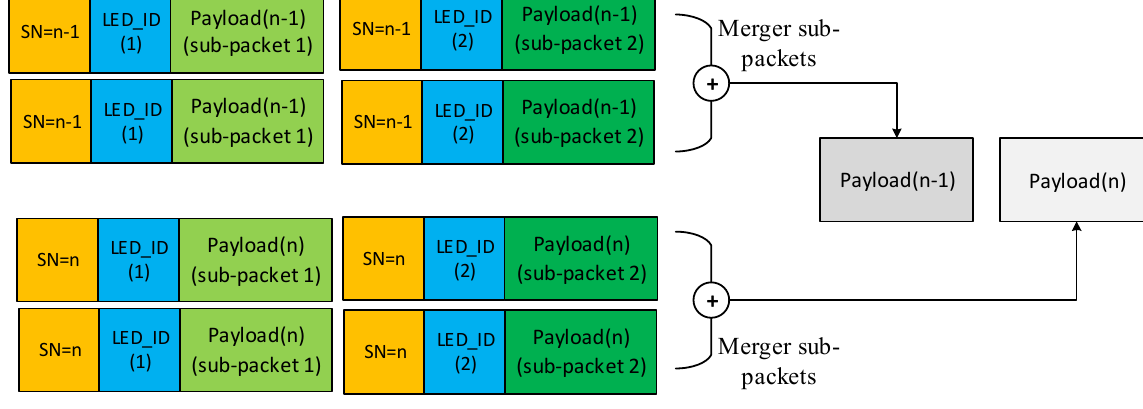
Figure 13. An example showing an oversampling case.